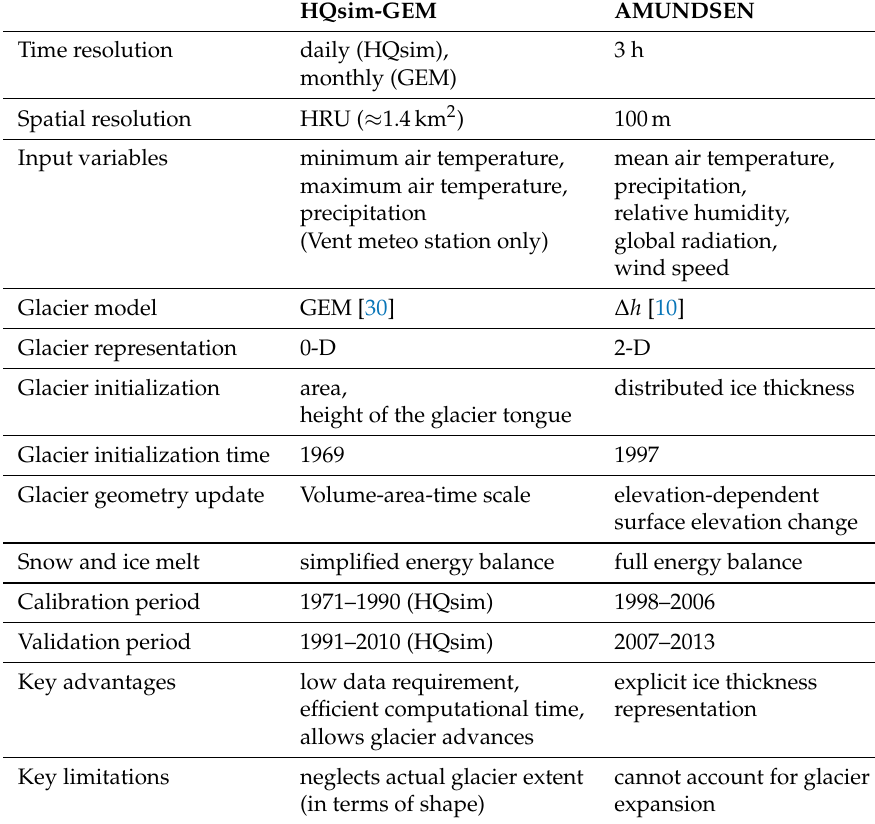
Table 1. Overview of the two glacio-hydrological models HQsim-GEM and AMUNDSEN. HQsim-GEM AMUNDSEN Time resolution daily (HQsim), 3 h monthly (GEM) Spatial resolution HRU ( ≈ 1.4km 2 ) 100m Input variables minimum air temperature, mean air temperature, maximum air temperature, precipitation, precipitation relative humidity, global